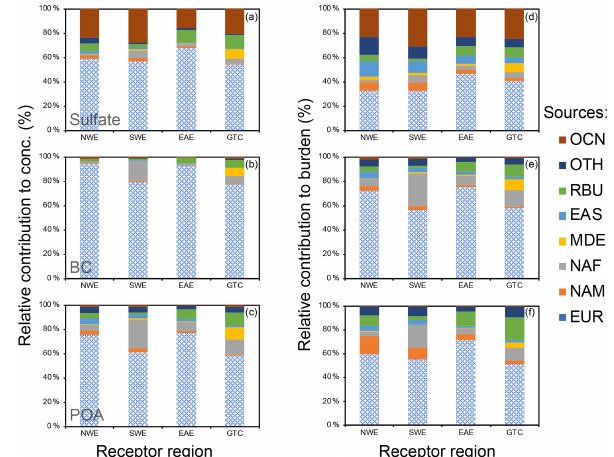
Figure 4. (a, b) Absolute (in micrograms per cubic) and (c, d) rela- tive contributions (in percent) to annual mean near-surface concen- trations of sulfate-BC-POA from local European emissions (EUR) and emissions outside the Europe (Non-EUR), respectively, aver- aged over 2010–2018.